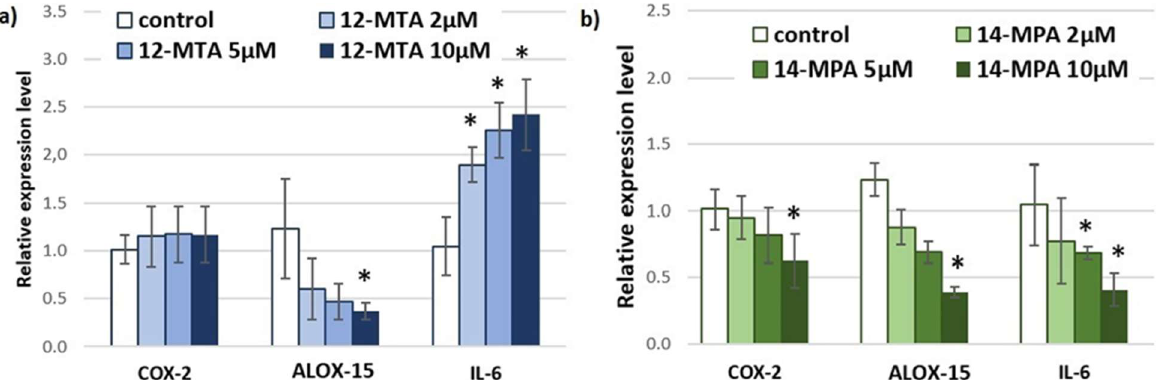
Figure 3. Relative expression level of selected genes involved in inflammation in visceral adipocytes incubated for 48 h in different concentrations of ( a ) 12-methyltetradecanoic (12-MTA) and ( b ) 14-methylpentadecanoic acid (14-MPA). Data are presented as mean ± SD. * p < 0.05 compared to control. COX-2 —cyclooxygenase 2; ALOX-15 —lipoxygenase 15; IL-6 —interleukin 6.